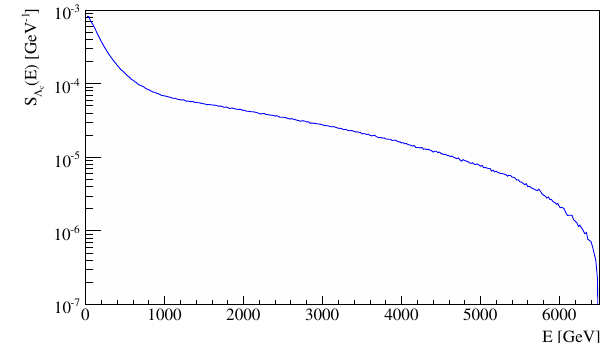
Fig. 11 Particle distribution at the target location for the two layouts. Projections of both planes are also reported